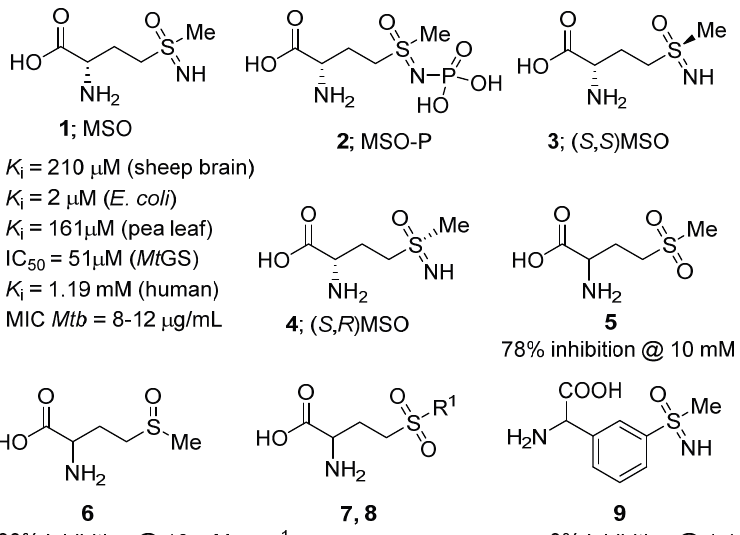
Figure 2. Structure and biological activities of MSO and analogues.